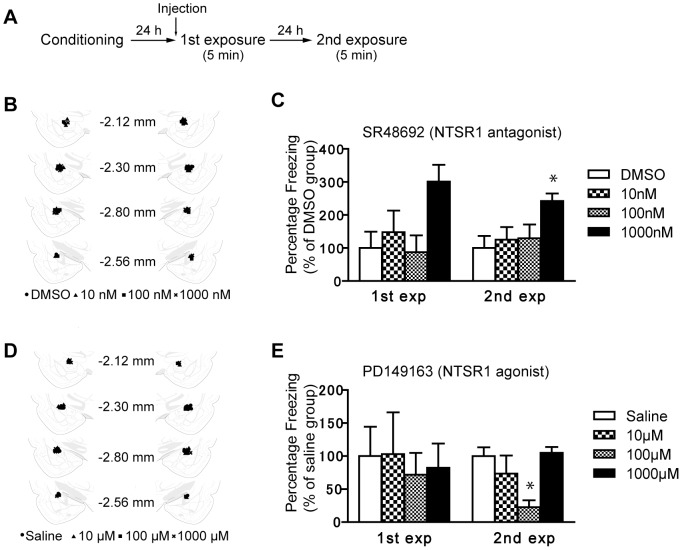
Effect of the NTSR1 agonist and antagonist in AMY on CFS.
A, Experimental design. B, D, Location of the needle tips for intra-AMY infusions of SR48692 (B) and PD149163 (D). Brain structure diagrams of coronal sections through AMY are adapted from the rat brain atlas of Paxinos and Watson [69] (2.12 – 2.56 mm posterior to bregma). C, Bilateral infusion of an NTSR1 antagonist (SR48692) dissolved in 0.5µl of DMOSO in AMY produced a significant increase in the freezing rate at a concentration of 1000 nM in the second exposure. E, Bilateral infusions of a NTSR1 agonist (PD149613) dissolved in 0.5 µl of saline into AMY produced a significant decrease in the freezing rate at a concentration of 100 µM at the second exposure (n = 7 – 8 rats per all groups; *p<0.05 vs. saline or DMSO control). Error bars represent SEM.